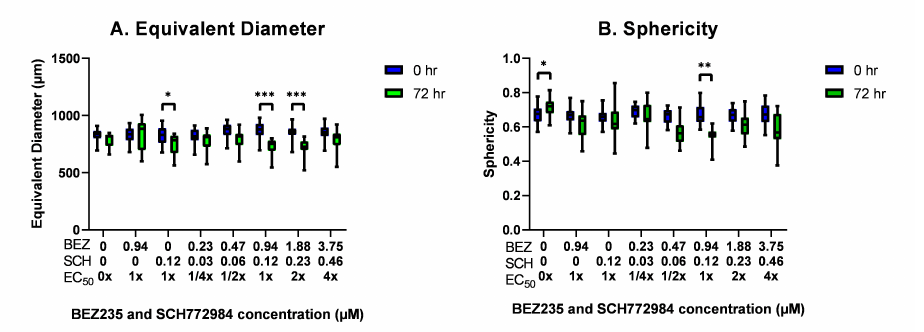
Figure 8. A box and whisker plot showing changes in diameter ( A ) and sphericity ( B ) after 72 h of exposure to BEZ235 and SCH772984, alone and in combination. Statistical significance is at p < 0.05 and is in comparison to the initial diameter or sphericity. The statistically significant differences are indicated as p < 0.05 (*), p < 0.01 (**) and p < 0.001 (***), as determined by RM two-way ANOVA with Sidak’s multiple comparison test (n =